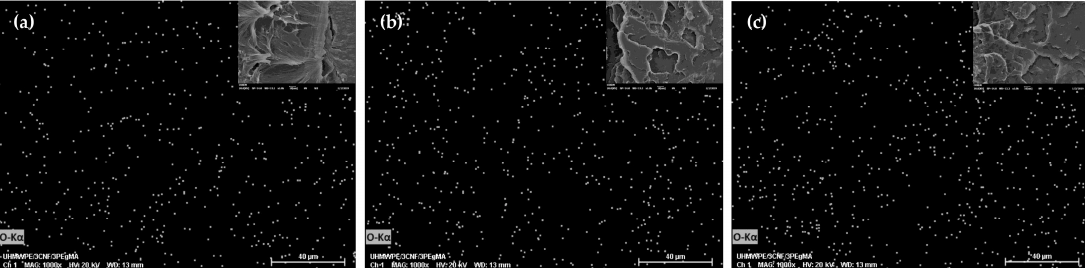
Figure 7. SEM-EDS images of UHMWPE/CNF bionanocomposites fabricated at a rotational speed of ( a ) 30 rpm, ( b ) 45 rpm, and ( c ) 60 rpm with constant temperature (170 °C) and mixing time (30 min).